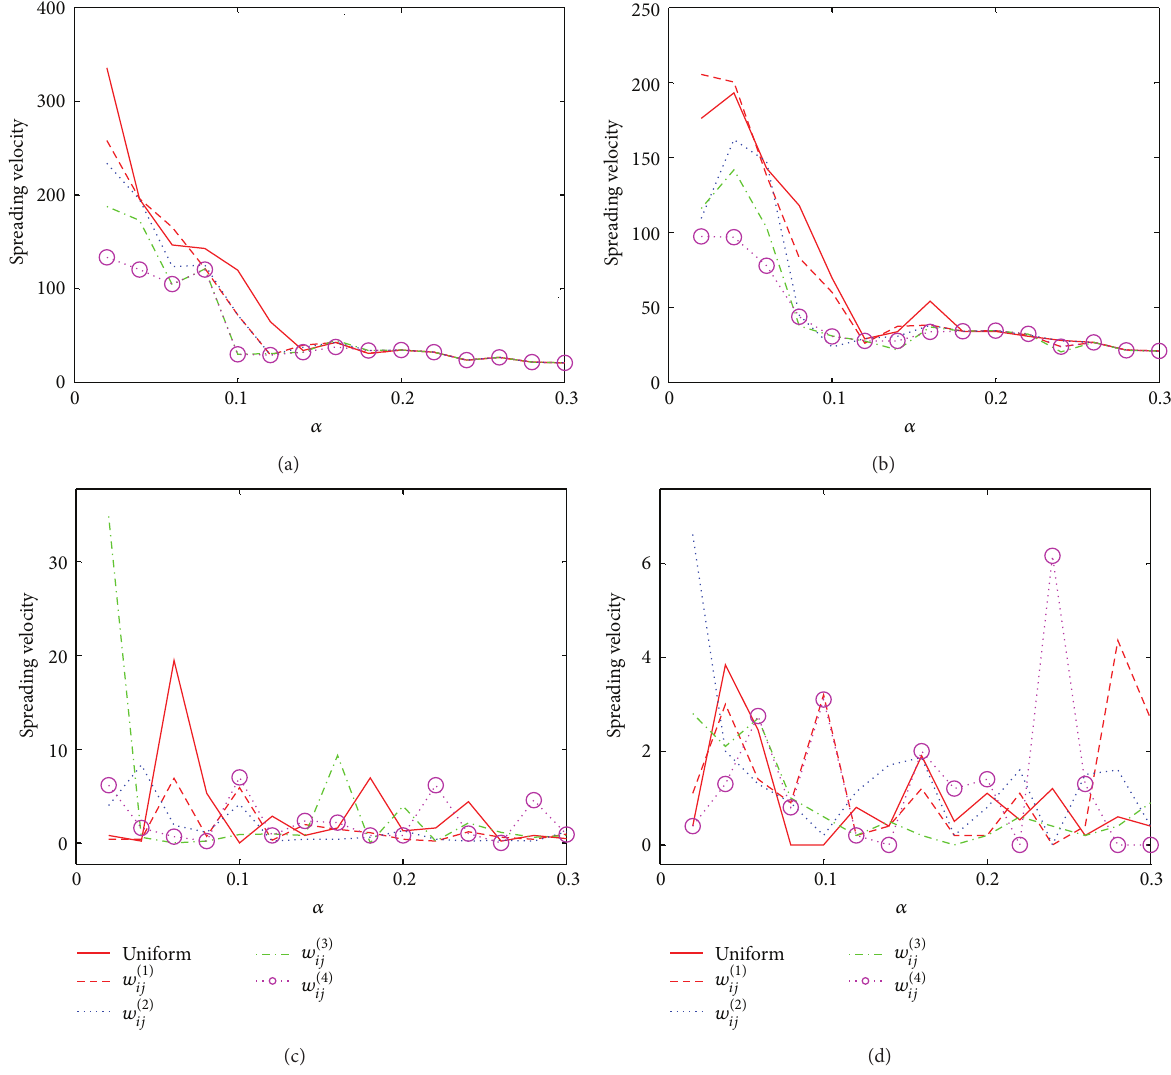
Figure 5: After the cascade stops, the spreading velocity 𝑉 of failures in autonomous system network as a function of 𝛼 for different strategies with (a) 𝜏 = 20 under HL attack, (b) 𝜏 = 100 under HL attack, (c) 𝜏 = 20 under RA attack, and (d) 𝜏 = 100 under RA attack, respectively. Here (c) and (d) are averaged over 20